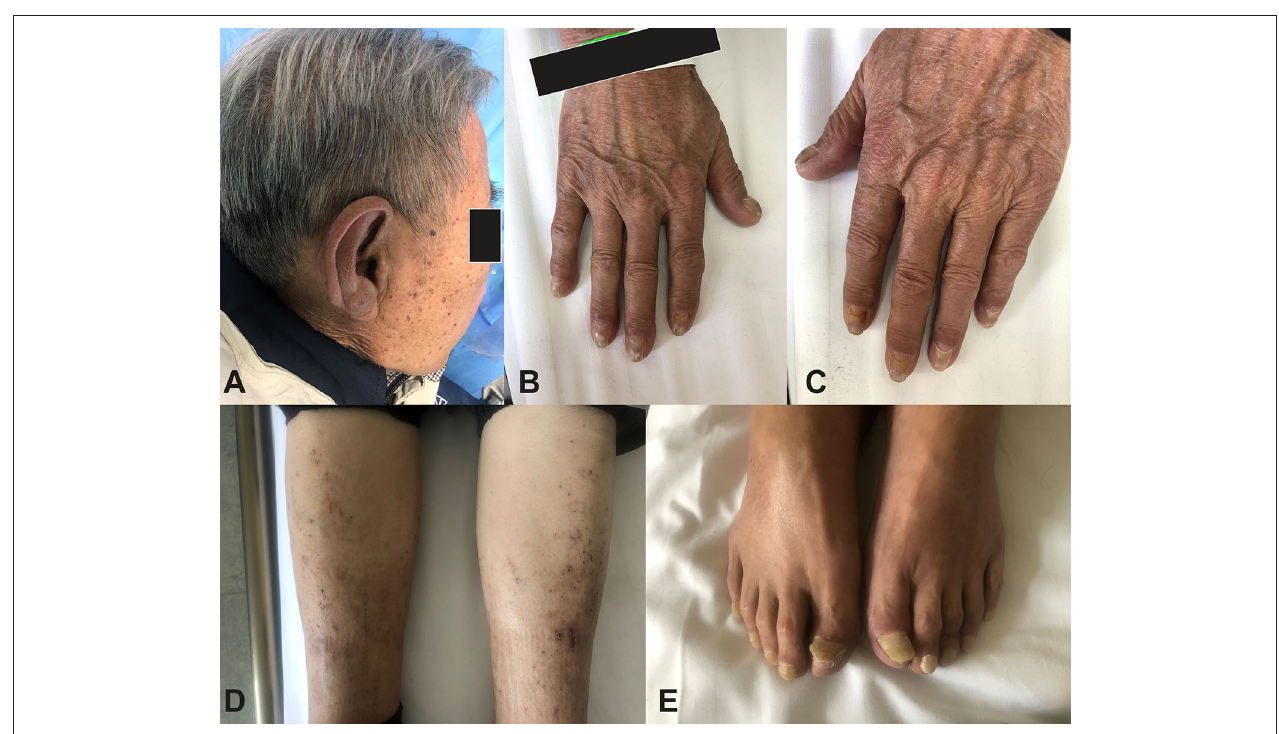
FIGURE 1 | Clinical manifestation of the patient. (A) Skin hyperpigmentation and alopecia. (B,C) Skin hyperpigmentation and onychodystrophy. (D) Hyperpigmentation and lower limb edema. (E) Onychodystrophy (toenail).